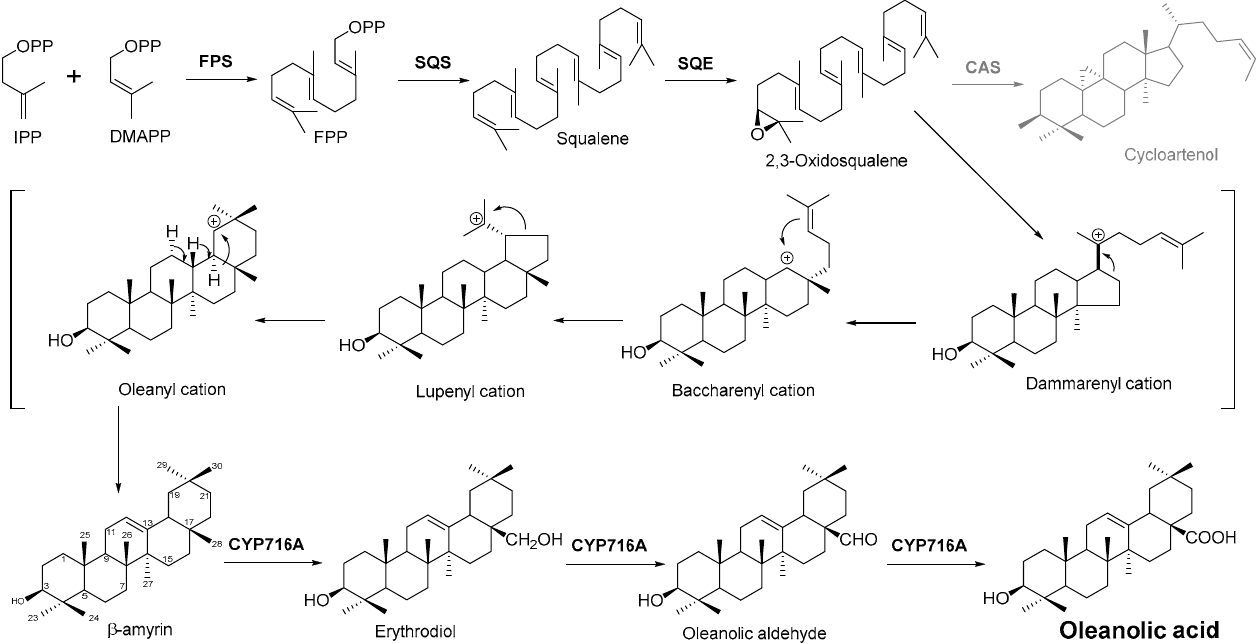
Figure 3. Biosynthesis pathway of terpenoid antimicrobial agent oleanolic acid. FPS, farnesyl diphosphate synthase; SQS, squalene synthase; SQE, squalene epoxidase; CAS, cycloartenol synthase.